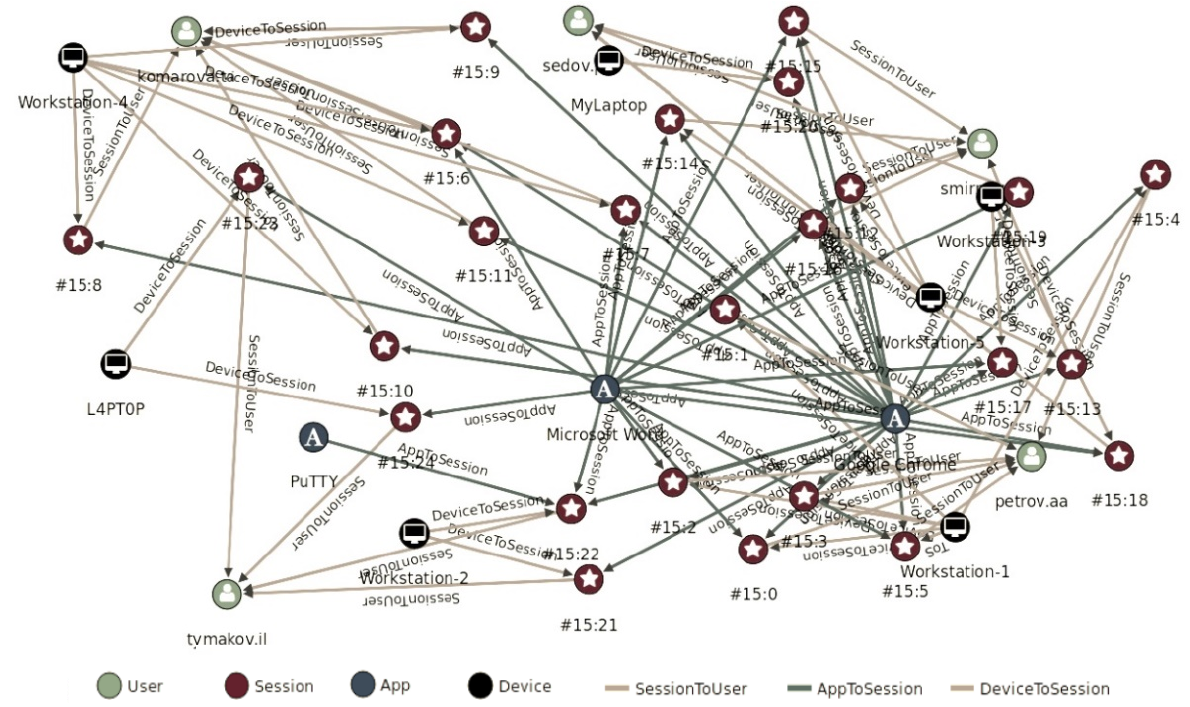
Figure 6. Graphical representation of the